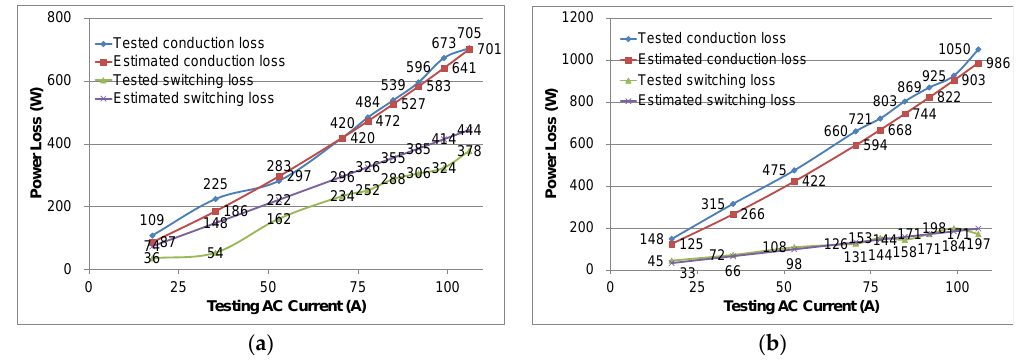
Figure 12. Comparison of tested and estimated power losses for the ( a ) 3L-NPC and ( b ) 5L-HANPC.